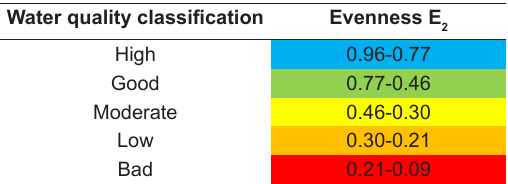
Table 2. Reference values of Evenness E phytoplankton classifying the water quality (Spatharis & Tsirtsis, 2010).